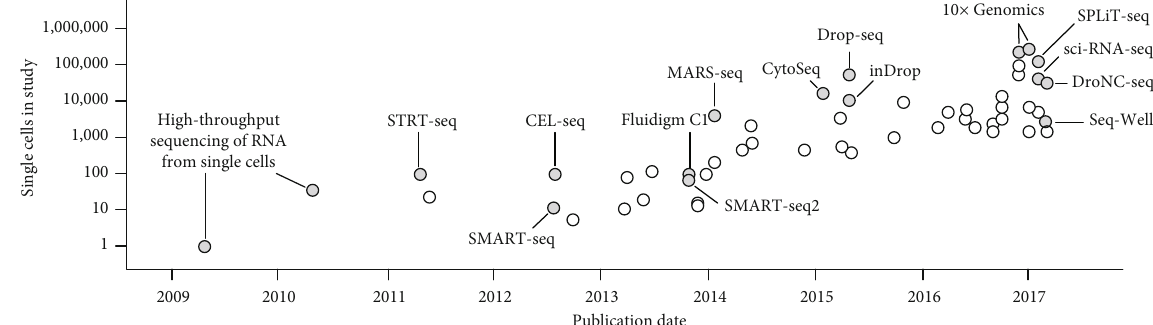
Figure 1: scRNA-seq technologies that have been critical to allowing increments in experiment scale. Achievements over the past three years have more or less continued this pace; for example, combinatorial fl uidic preindexing has increased the throughput of droplet-based single- cell RNA sequencing up to 15-fold. Figure adapted from references [133,